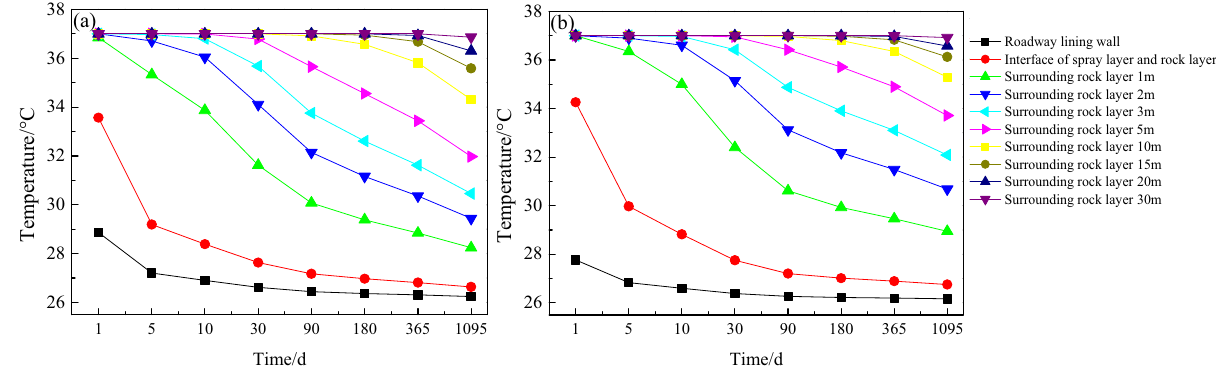
Figure 8: Temperature distributions of roadway surrounding rock under two working conditions: ( a ) normal; ( b ) thermal insulation.